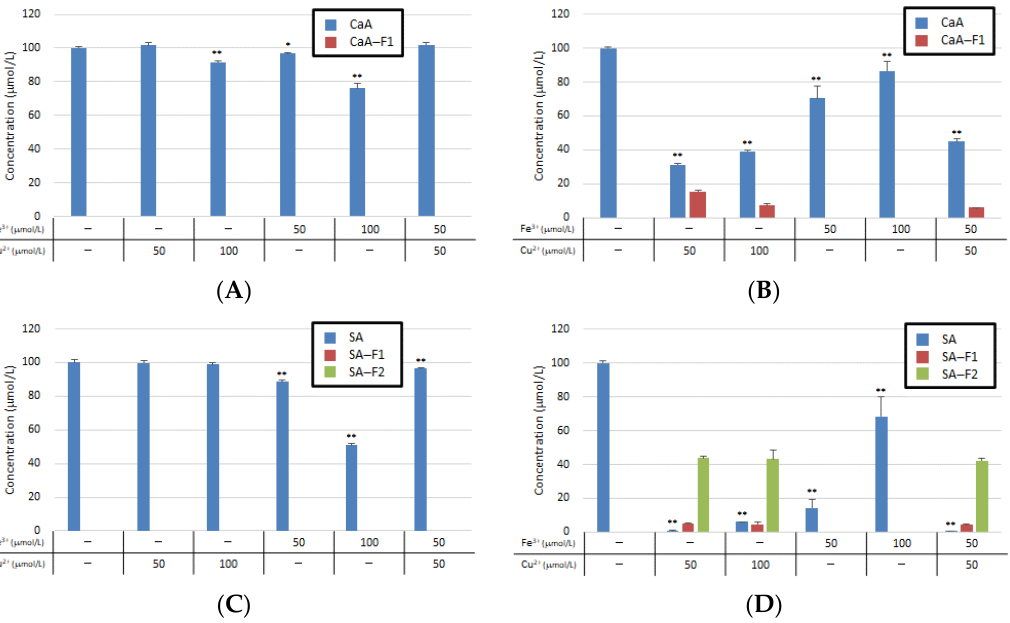
Figure 6. Co-interaction of metal ions with ( A ) CaA in FaSSGF; ( B ) CaA in FaSSIF; ( C ) SA in FaSSGF; ( D ) SA in FaSSIF. * and ** indicate significantly different values at p < 0.05 and p < 0.01, respectively. Table 1. Trolox equivalent antioxidant capacities (mmol Trolox equivalent/mmol) for various HCAs and related compounds. Results are presented as the mean ± SD for three independent experiments. HCAs DPPH